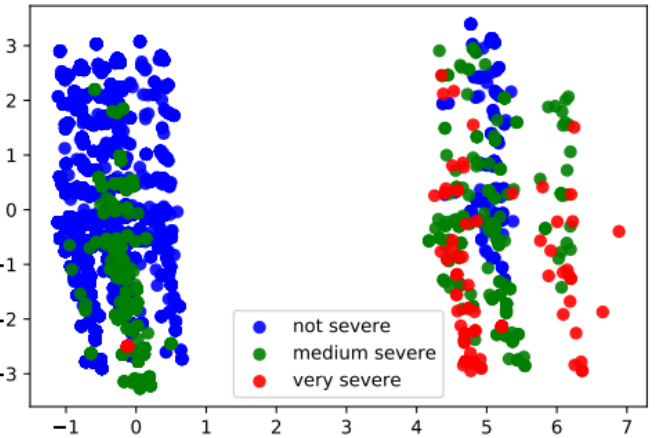
Figure 4. Visualization of the classification of patients according to the first two principal components. The colors represent the three levels of severity identified by